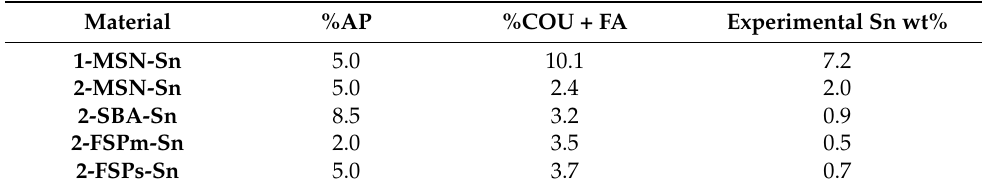
Table 2. Determination of the quantity of ligand and tin by thermogravimetry or ICP-MS,